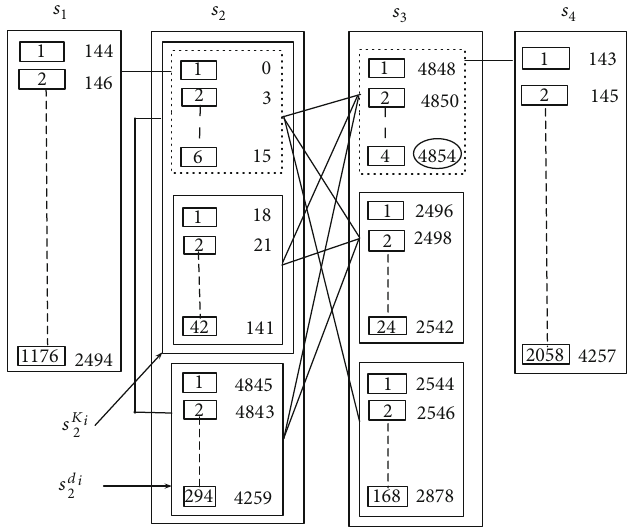
Figure 1: L ð 3, 2, 1 Þ labeling of Γ of order 7 4 × 5